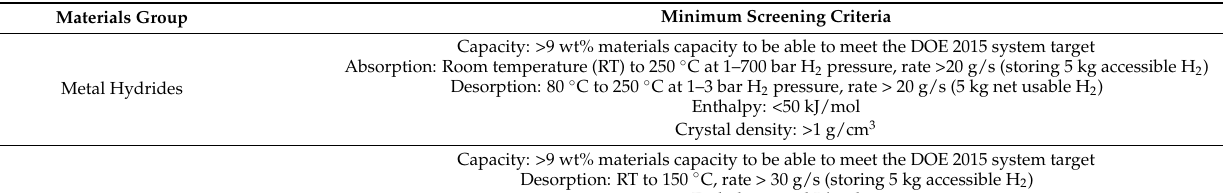
Table 2. Minimum screening criteria for each materials group. Minimum Screening